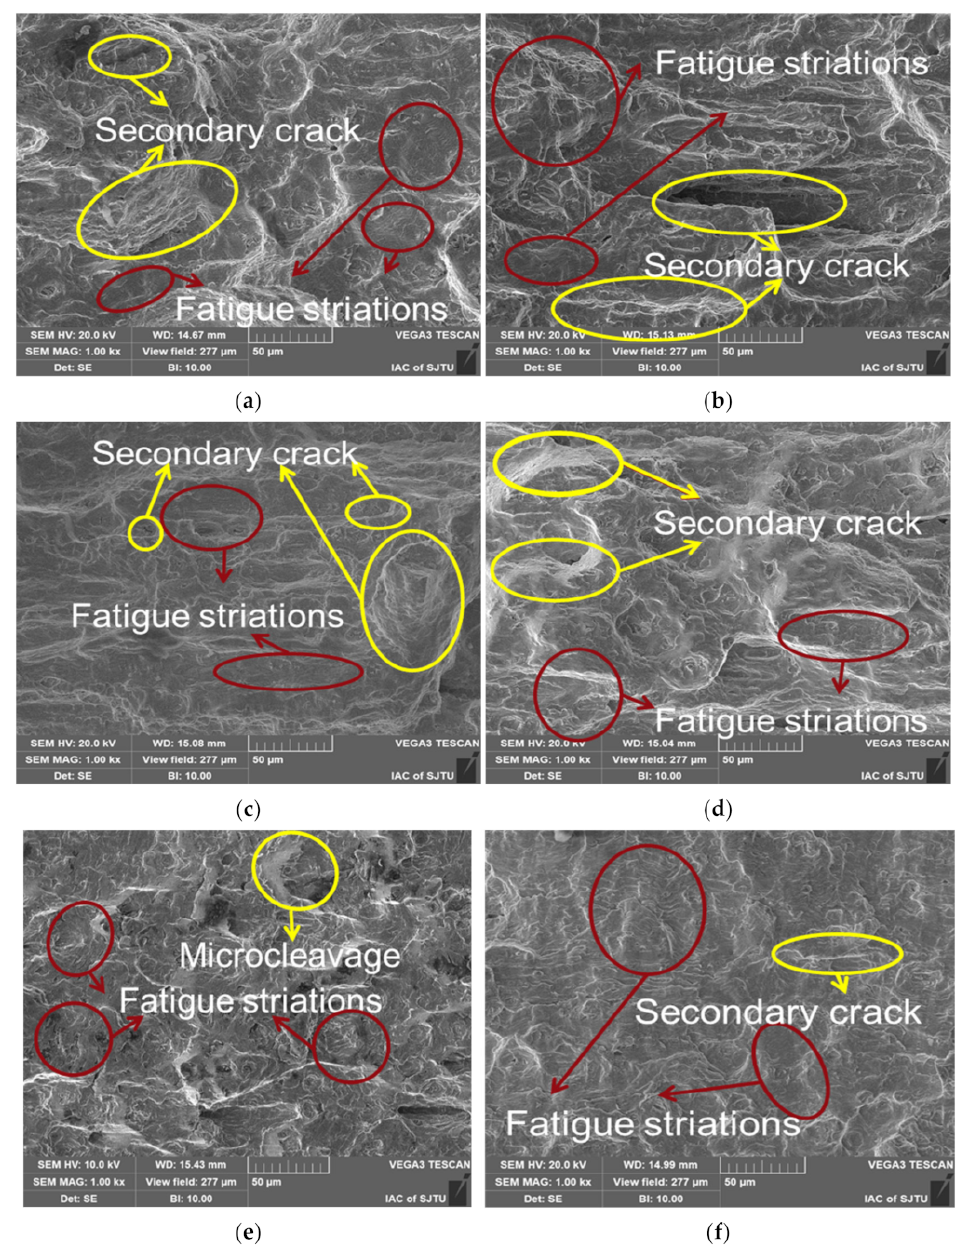
Figure 13. SEM micrographs revealing typical structure in crack propagation zone for specimens with LSP (( a ) 1.2% strain amplitude, ( c ) 0.8% strain amplitude, ( e ) 0.4% strain amplitude) and specimens without LSP (( b ) 1.2% strain amplitude, ( d ) 0.8% strain amplitude, ( f ) 0.4% strain